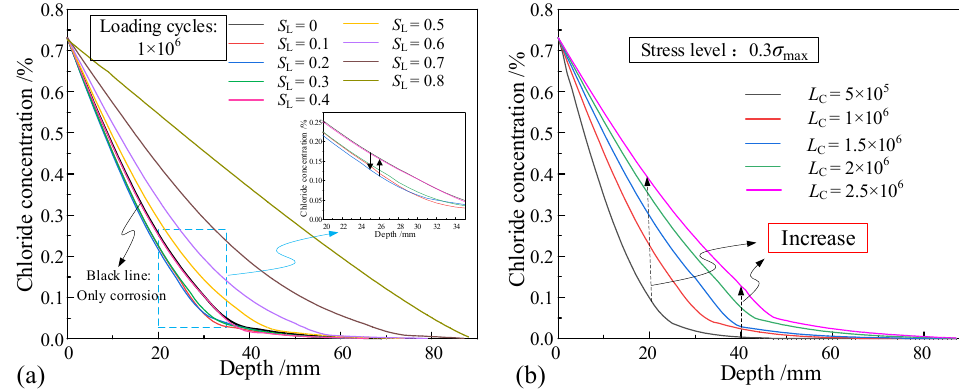
Figure 9. Chloride concentration in unsaturated concrete: ( a ) effect of different repeated loading stress levels and ( b ) effect of different repeated loading cycles.